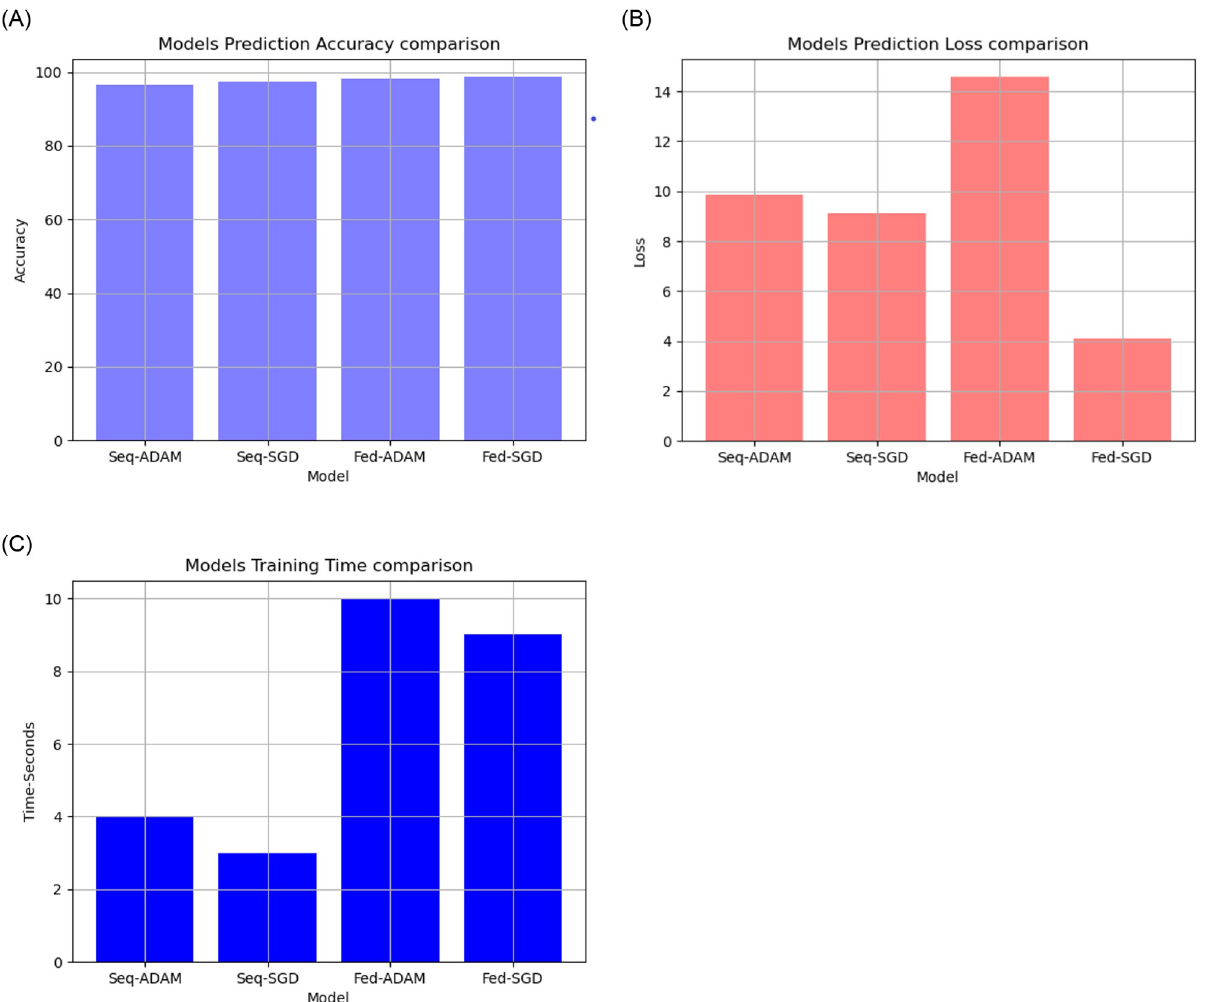
Fig 7. Model accuracy, loss and time comparison on patient’s chest x-rays dataset.